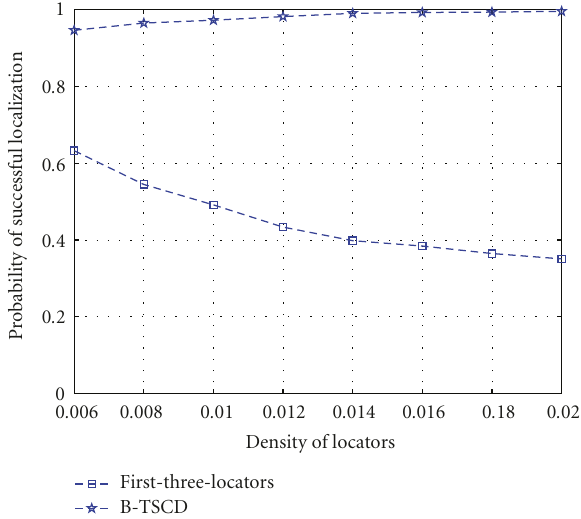
Figure 5: Performance of the first-three-locators scheme and the B-TSCD scheme.